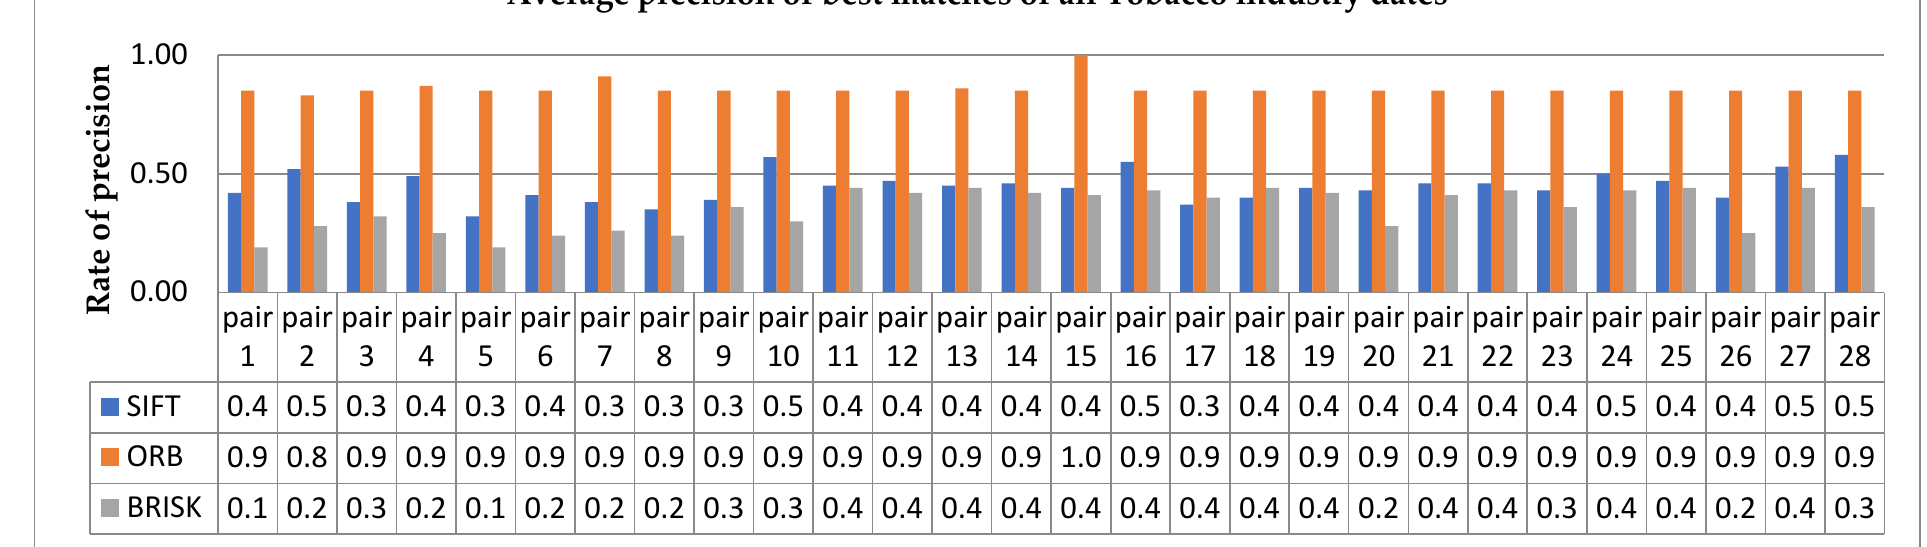
Figure 23. Tobacco industry. Average precision each year compared to all the others.